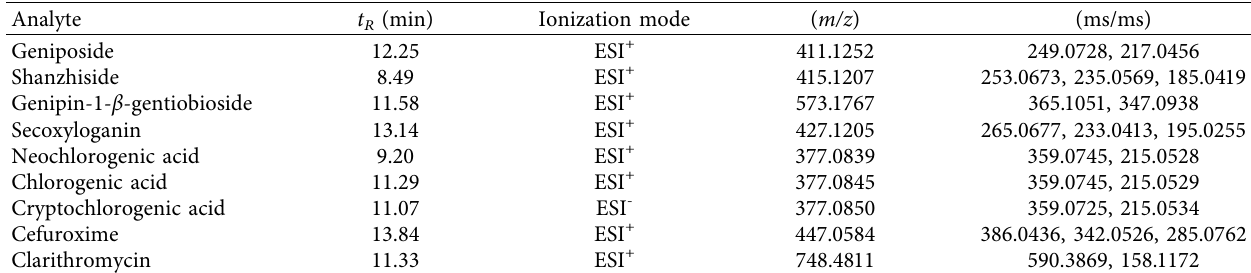
Table 1: The related MS data of seven prototypes with